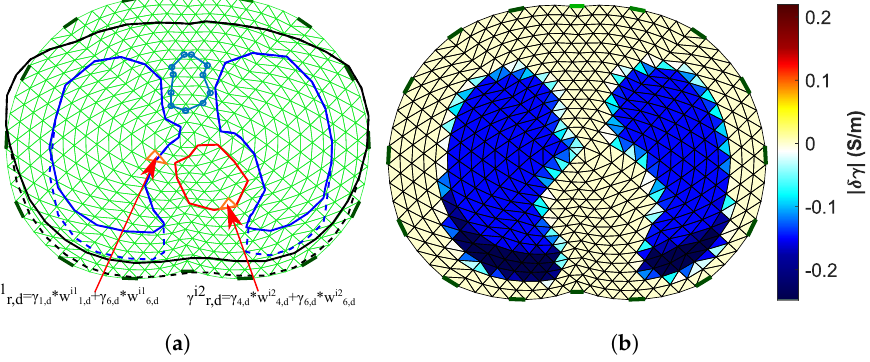
Figure 7. ( a ) Visualization of the process to obtain the Ω domain reference image. ( b ) The Ω domain reference image (15 kHz